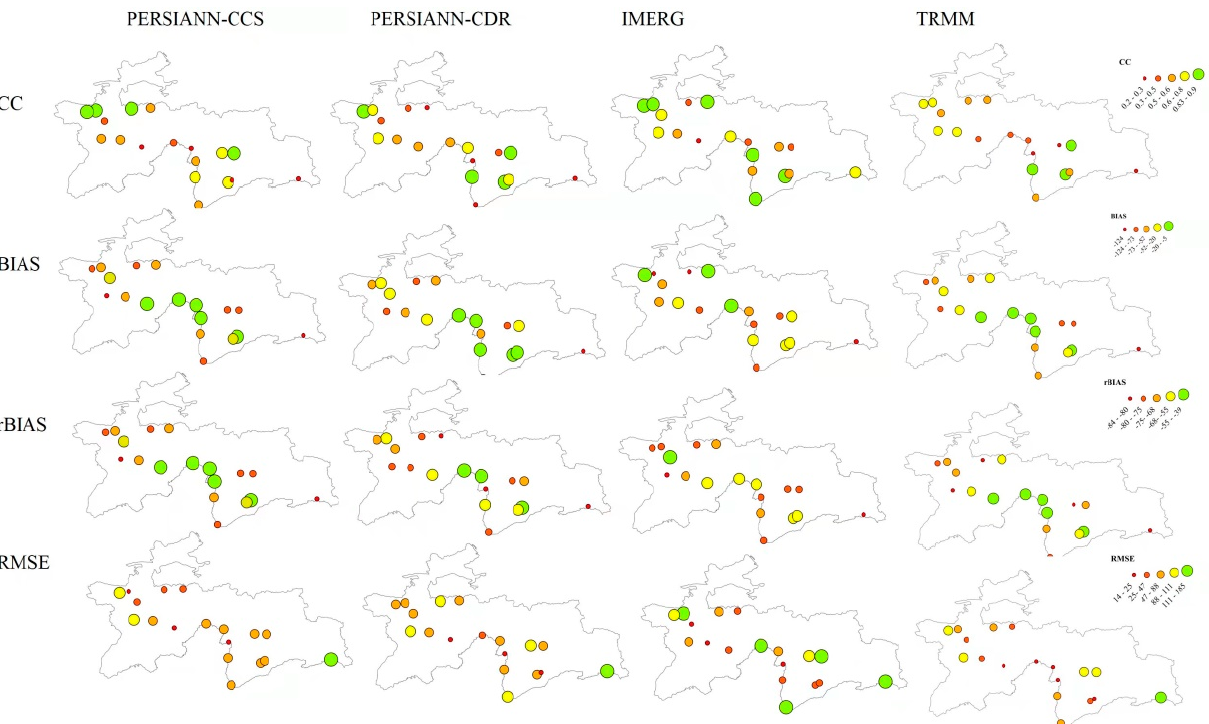
Figure 8. Spatial distribution of evaluation indices’ (CC, BIAS, rBIAS, and RMSE) for all SBPD.